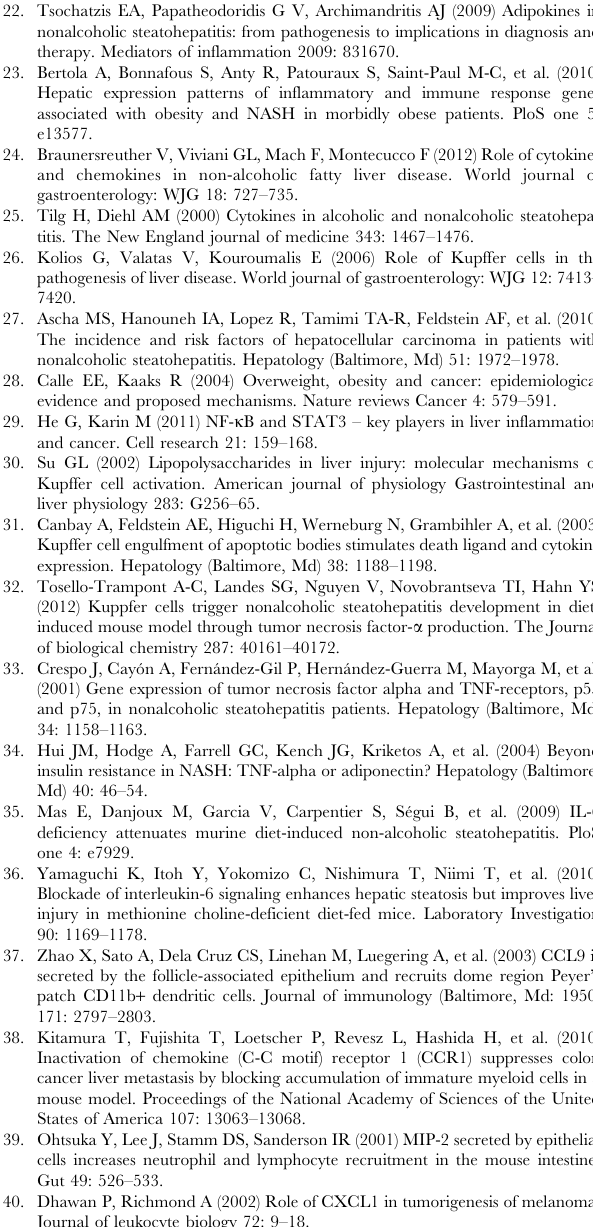
Table S1 Inflammatory cell profiles in the spleen of normal vs steatotic